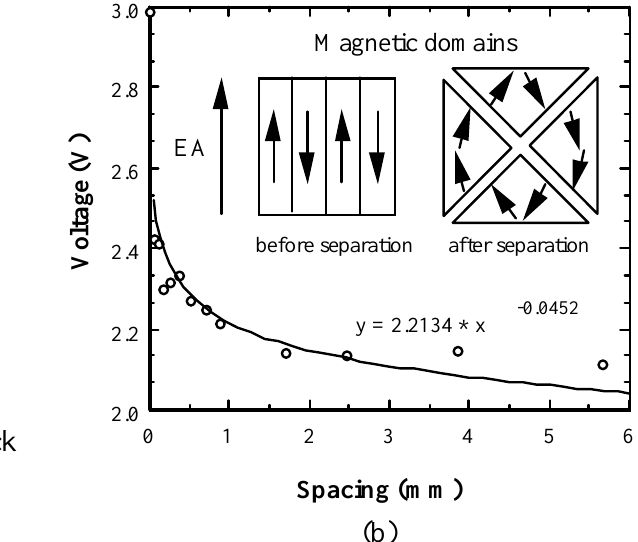
Figure 1. (a) Schematic drawing of the magnetostatic coupling glucose sensor. Initial spacing between elements is 50 µm, distance expands upon wetting and exposure to glucose. (b) Measured voltage spike amplitude vs. element spacing as a function of measured distance across diagonal. Domain drawing is